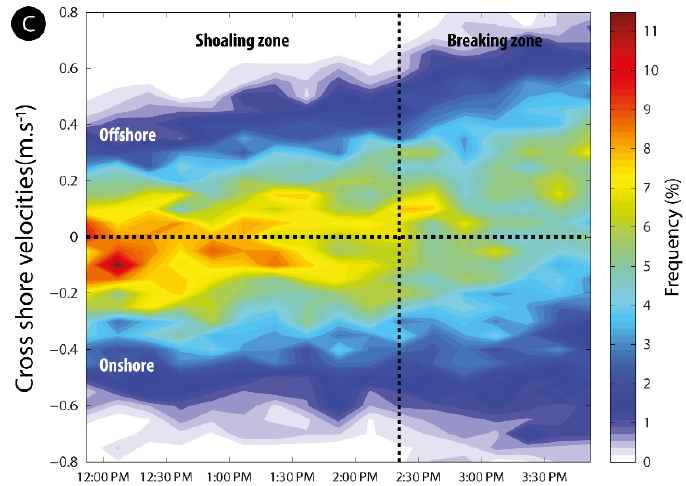
Figure 13. Temporal variations in frequency of onshore- and offshore-directed cross-shore current velocities over bar B3 (see Figure 2D for location) under non-breaking and breaking wave processes as water depth decreased during falling tide during moderate energy conditions (offshore H s ≈ 1.2 m) on ( A ) 4 June and ( B ) 5 June 2013, and higher energy conditions (offshore H s ≈ 1.4–1.5 m) on ( C ) 6 June 2013.